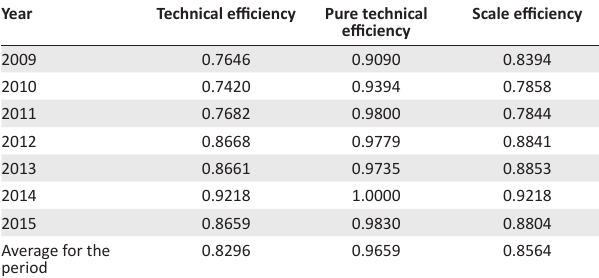
TABLE 2: Average technical, pure technical and scale efficiency. Year